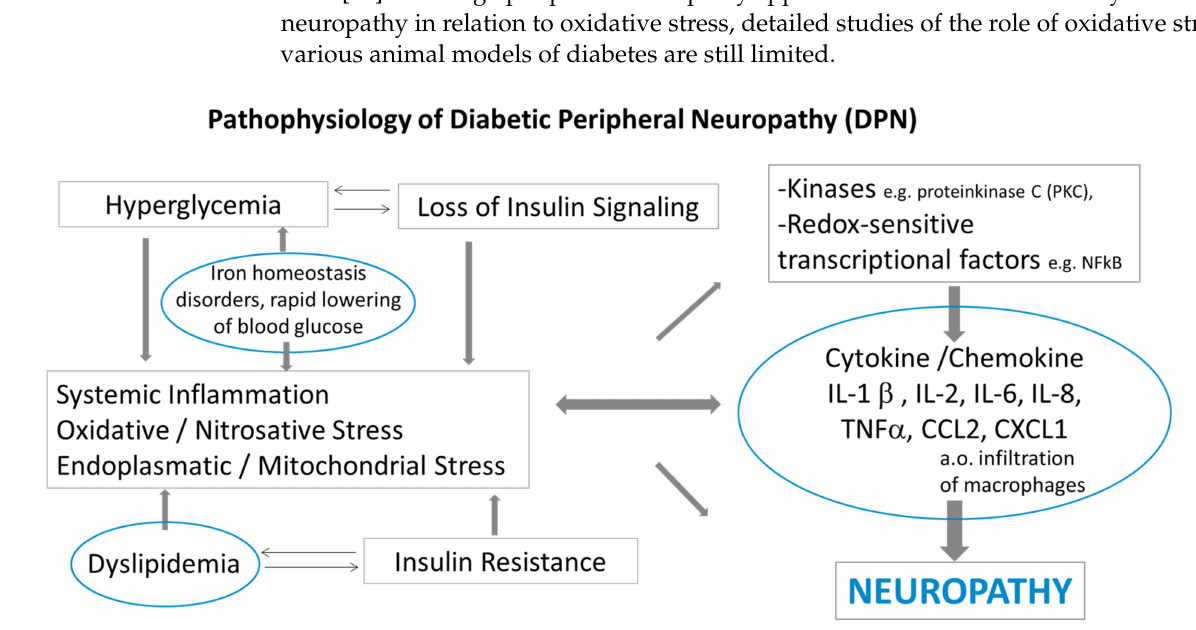
Figure 2. Pathophysiology of diabetic peripheral neuropathy, modified according to Pop-Busui, 2016 [40]. The relationship between inflammation in diabetes and damage of peripheral nerve fibers: hyperglycemia and insulin loss/resistance lead to dyslipidemia and oxidative/nitrosative stress of endoplasmic reticulum and mitochondria. These processes may contribute to accumulation of ROS (reactive oxygen species), inflammation and cellular damage. The infiltrated macrophages in the peripheral nerves trigger the production of pro-inflammatory factors: cytokine and chemokine, which promote inflammation and damage of nerve fibers. Disorders of iron homeostasis and rapid lowering of blood glucose enhances the inflammatory process of peripheral nerves and appears to affect